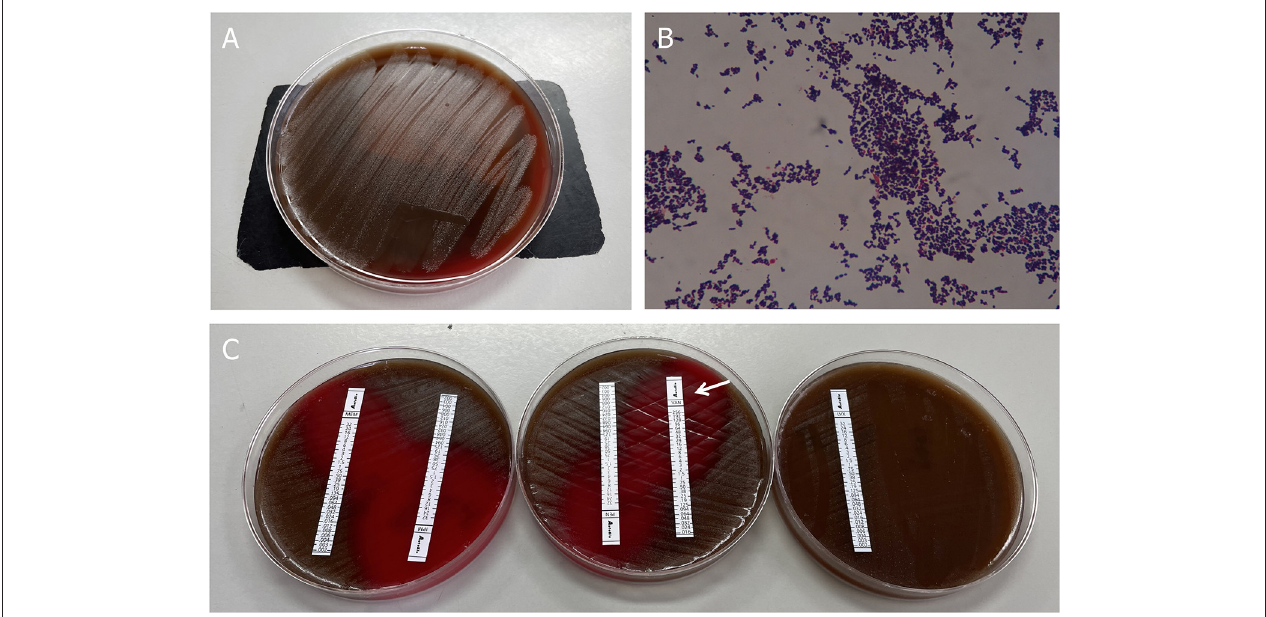
FIGURE 2 | Blood culture results. (A) Growth of colonies of Abiotrophia defectiva in the blood agar. (B) Gram stain reveals Gram-positive pleomorphic coccobacilli, arranged in chains (original magnification, 1,000X). (C) Antimicrobial susceptibility testing demonstrated susceptibility to vancomycin, imipenem, and meropenem, but was resistant to penicillin and levofloxacin.